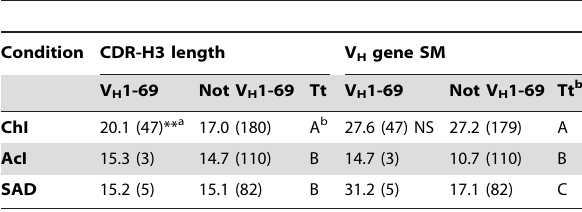
Table 4. Association between V H 1-69 gene usage, CDR-H3 length and number of somatic